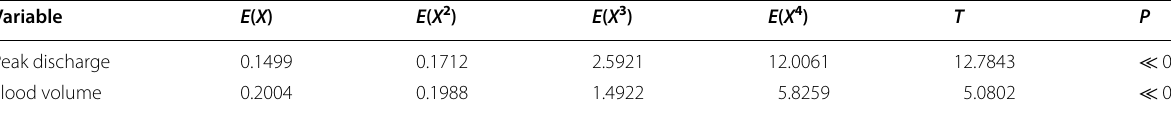
Table 6 Sample statistics for scaled peak discharge and flood volume